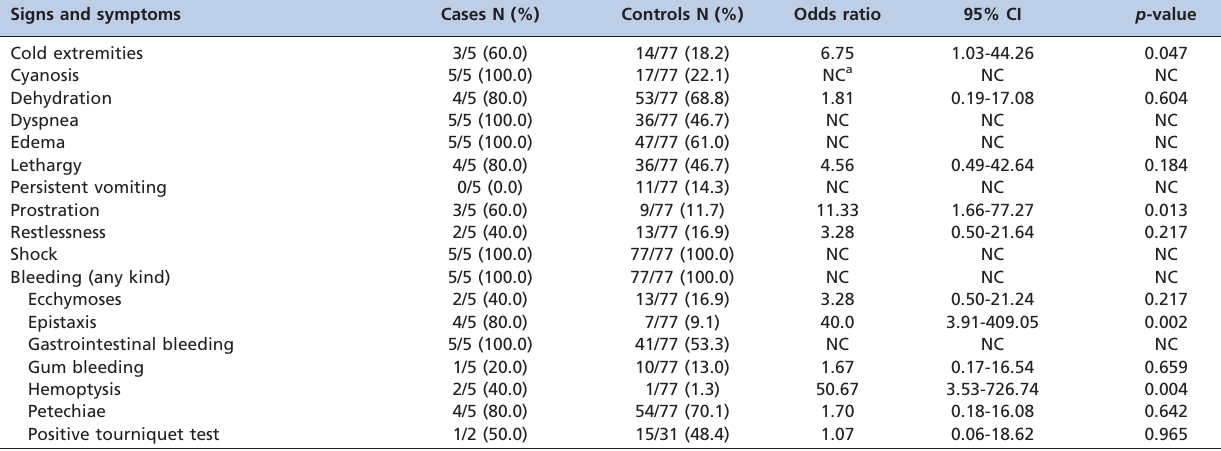
Table 4 - Association between clinical characteristics and death in children admitted to the Hospital of the Universidade Federal do Maranha˜o with severe